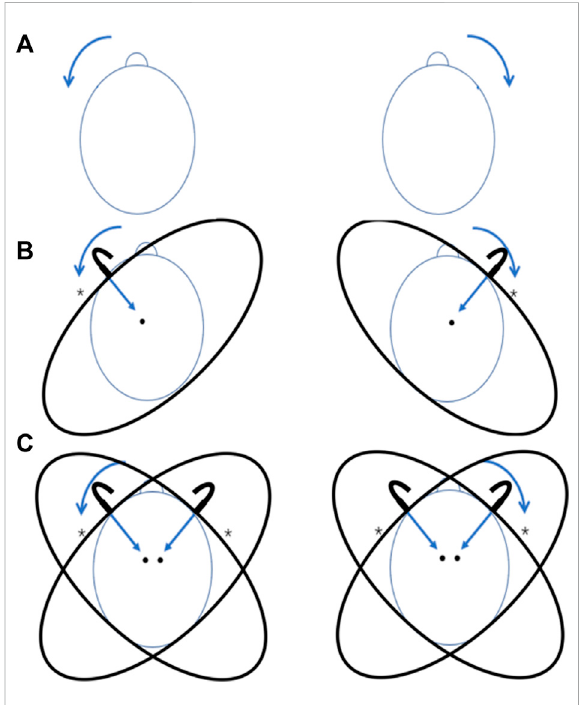
FIGURE 2 The rotation tasks at on no HR, unilateral and bilateral HR. (A) Subjects were asked to start the rotation tasks fi rstly on the left then the right; (B) The compressed sides of unilateral HR were set fi rstly on the left then the right, and subjects were asked to rotatetheirheadstothecompressedsiderespectively( fi rsttheleft then the right); (C) In bilateral HR, subjects were asked to start the rotation tasks fi rstly on the left then the right; *, the compressed side of HR; brow peak, the rotation